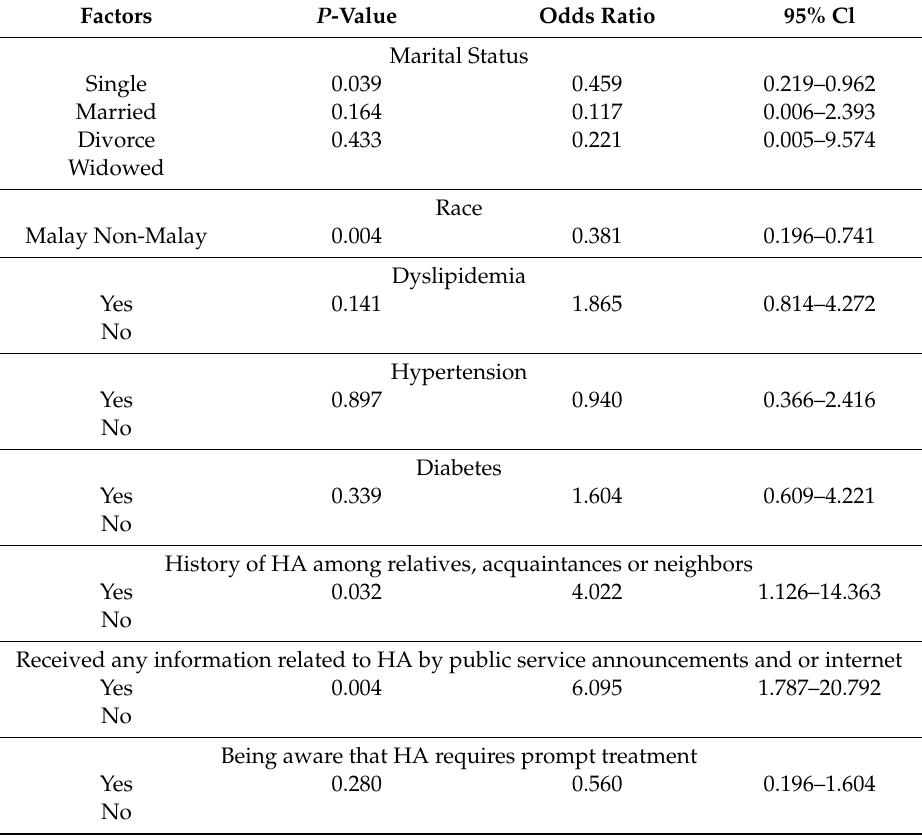
Multivariable logistic regression analysis factors related to knowledge of five heart attack